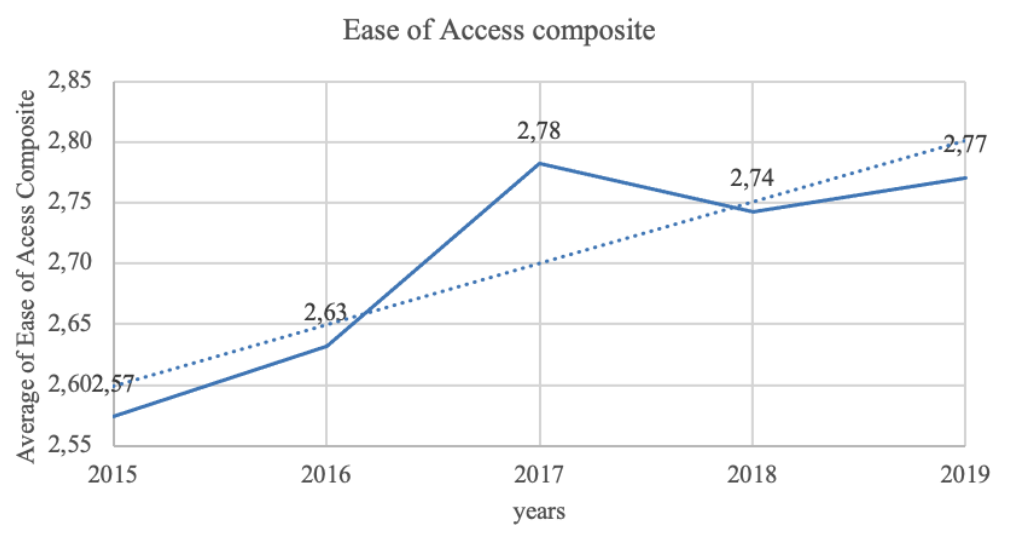
Figure 4: Trend on the overall of Ease of Access Composite; Source: Survey Data